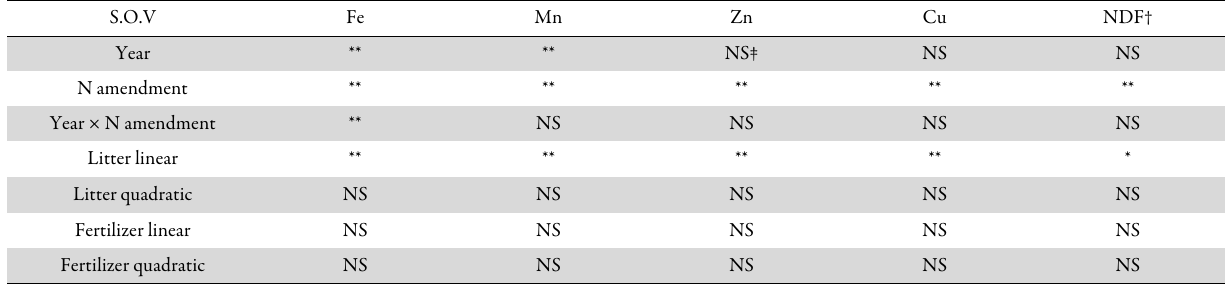
Table 2. The effects of N source and rate on micro nutrients concentration, and NDF of silage corn